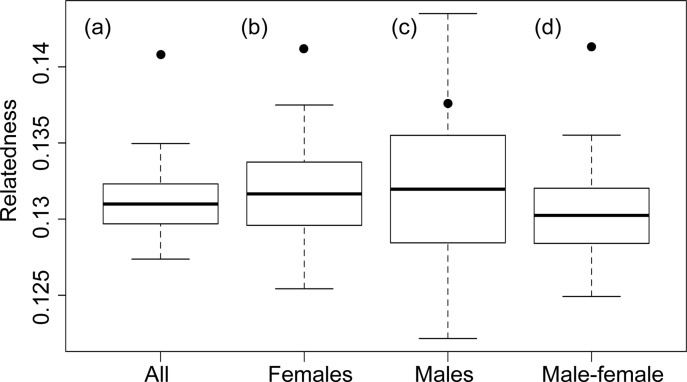
Modified boxplots depicting the simulated and observed relatedness of recaptured a) adults, b) females, c) males and d) males-females.The box depicts the 25th and 75th quartiles, the solid line is the median and the whiskers are the 2.5% and 97.5% percentiles.